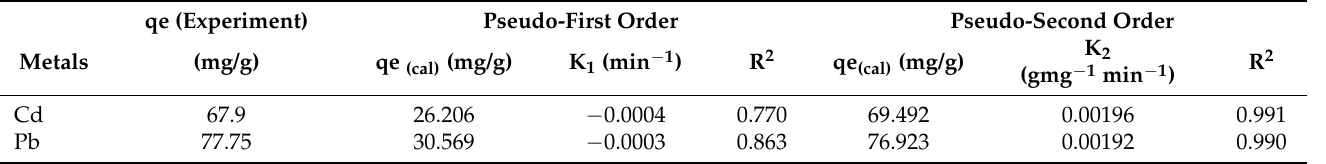
Table 1. Pseudo-first and pseudo-second order